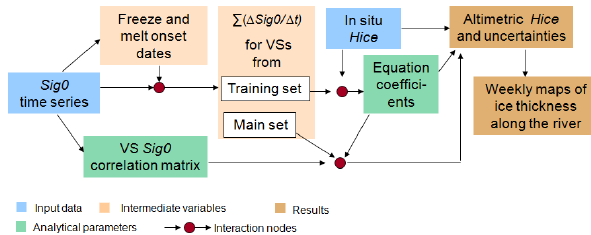
Figure 6. Processing scheme of ice thickness retrieval from altimet- ric